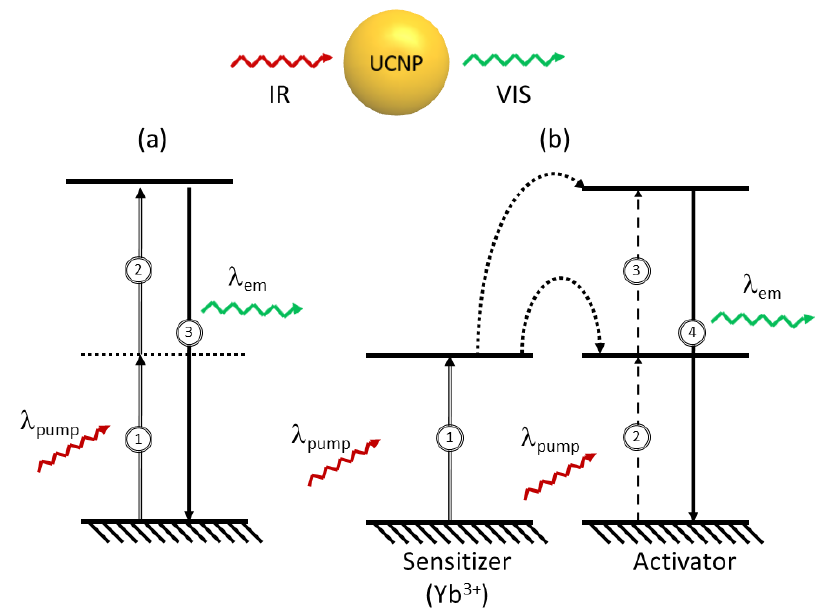
Figure 1. Principal mechanisms for upconversion ( a ) excited state absorption, ( b )